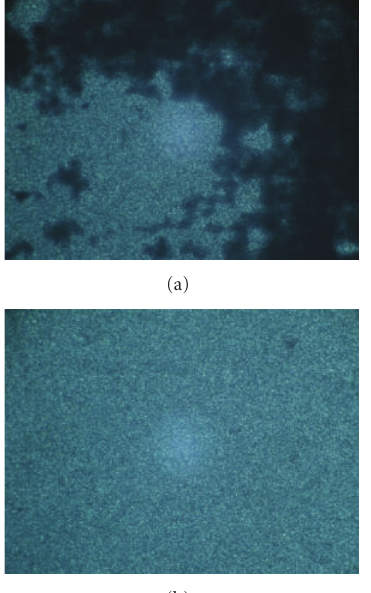
taken in the nematic region at 135.2 ◦ C and was identified